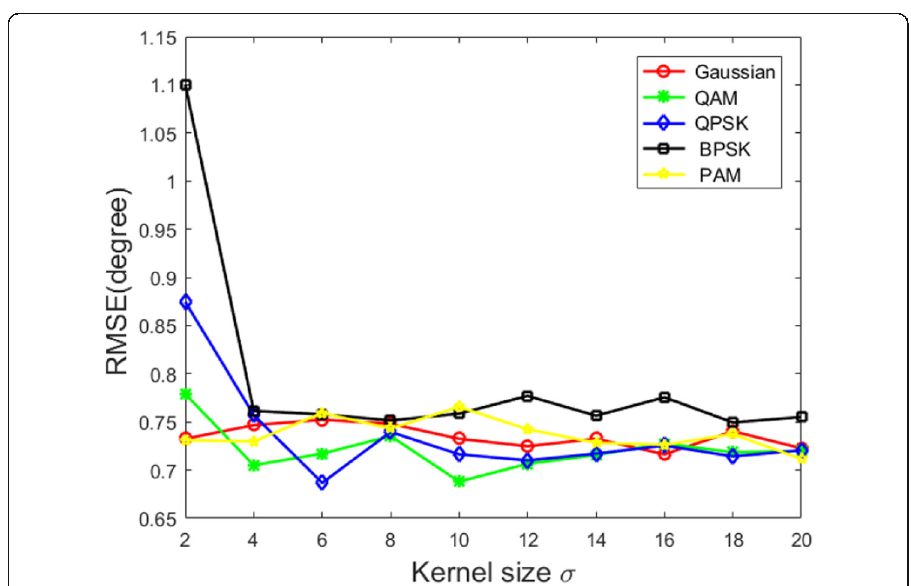
Fig. 9 RMSE against kernel size